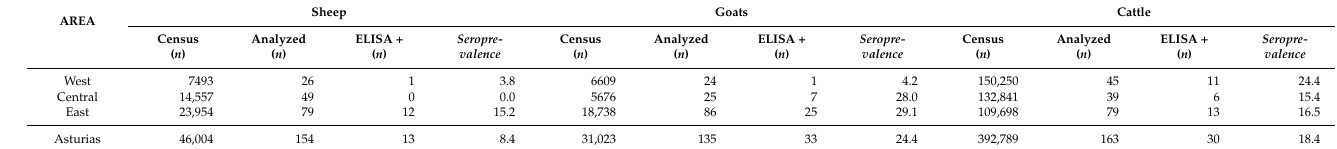
Table 1. C. burnetii seroprevalence in domestic ruminants in the three geographical areas of Asturias. AREA Sheep Goats